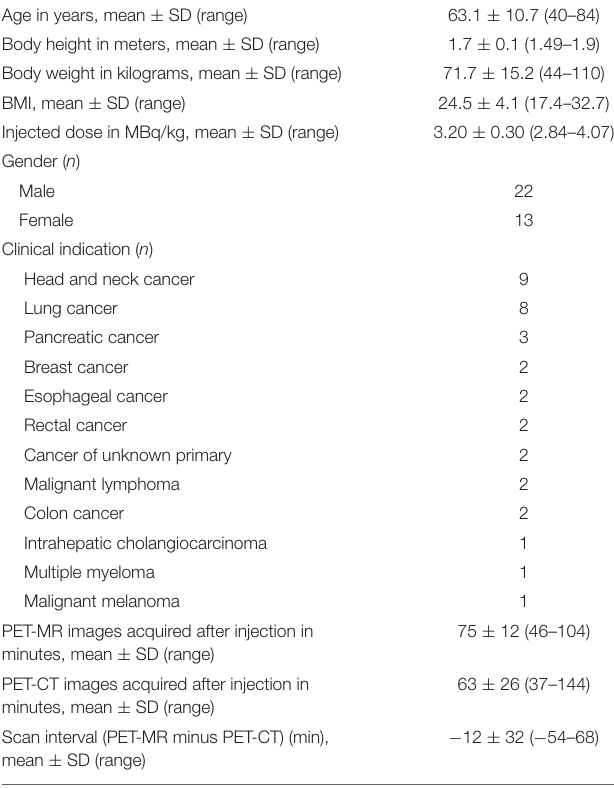
TABLE 1 | Demographic and clinical